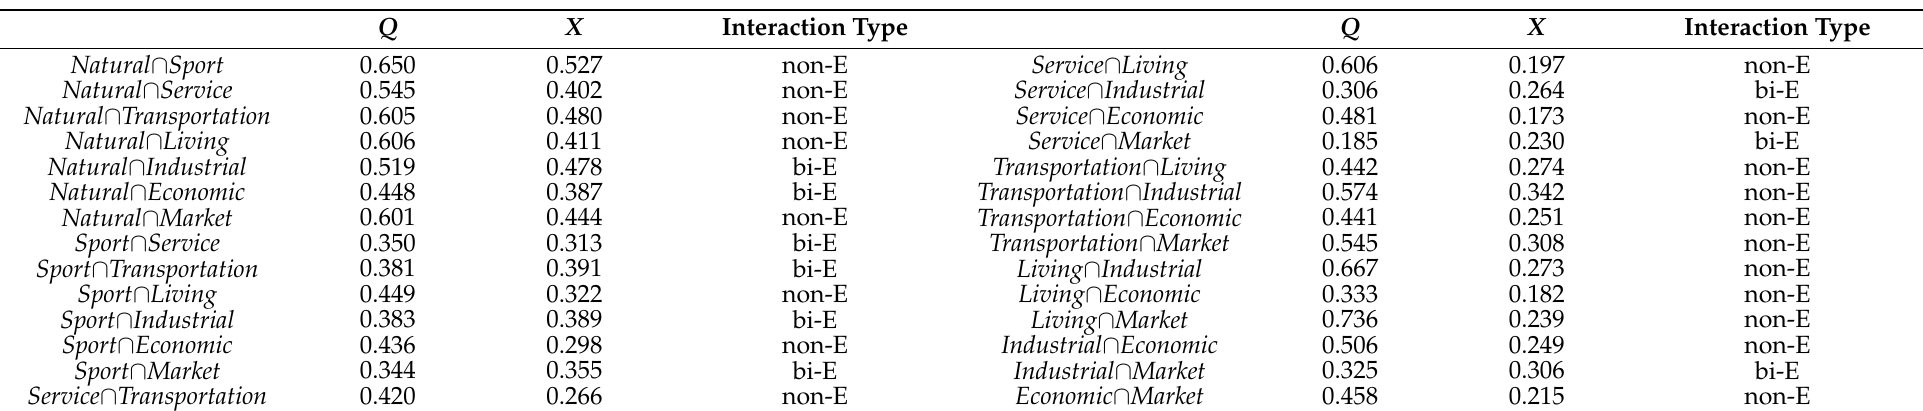
Table 3. Interaction results and types of detection